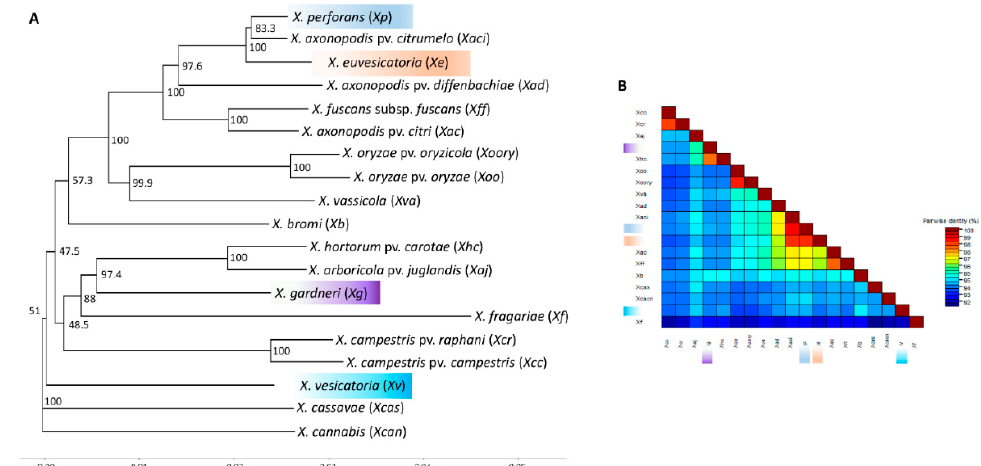
Figure 4. Phylogenetic positions of Xanthomonas euvesicatoria and X. vesicatoria and other Xanthomonas species using chromosomal replication initiator factor ( dnaA ), type I glyceraldehyde-3-phosphate dehydrogenase ( gapA ), DNA topoisomerase (ATP-hydrolyzing) subunit B ( gyrB ), hydroxymethylbilane synthase ( hmbs ), pyruvate dehydrogenase ( pdg ), molecular chaperone DnaK ( dnaK ), sugar ABC transporter permease ( lacF ), elongation factor G ( fusA ), and citrate synthase ( gltA ) genes. ( A ) Phylogenetic tree showing the positions of Xanthomonas species, ( B ) color-coded heat map generated from concatenated sequences of nine complete genes (mentioned above). Numbers on the nodes represent bootstrap values and are presented as a percentage of 1000 replicates. Line in the bottom represents the scale bar that shows the distance between the species.